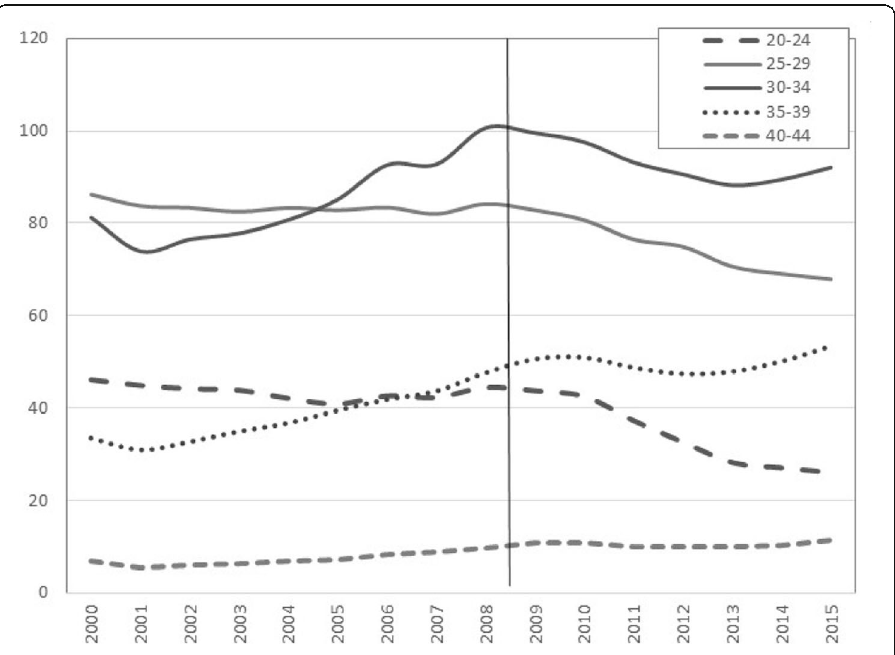
Fig. 2 Age-specific fertility rates (births per 1000 women), 2000 – 2015. Source: EL.STAT. (2017) and own